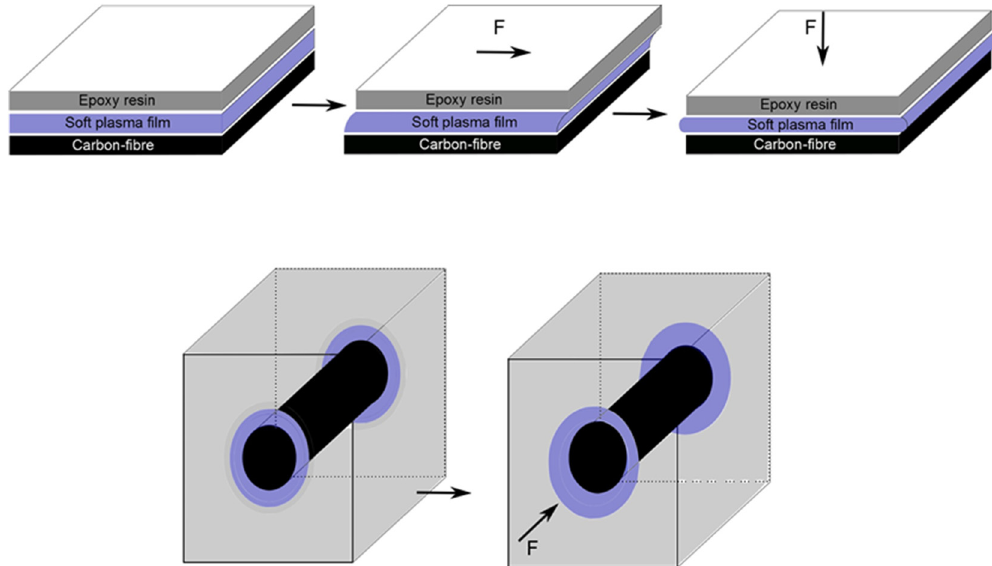
Figure 1. Schematic of a single layer plasma deposited film acting as a damping layer between fibres and matrix.